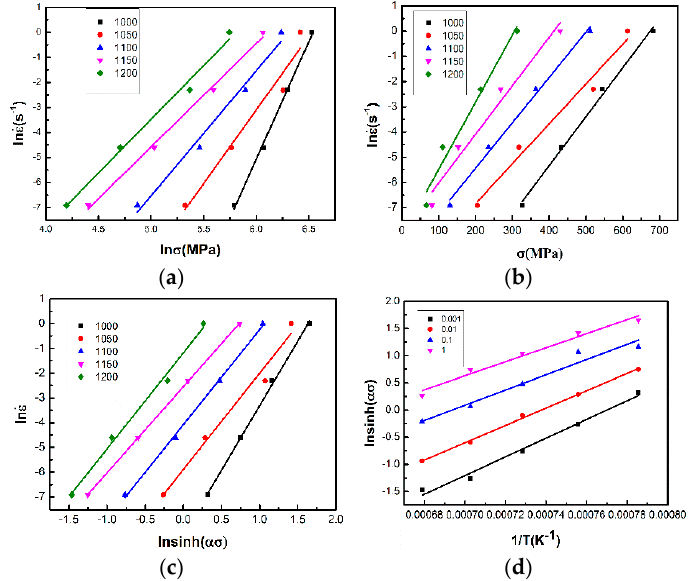
Figure 3. Plot of ( a ) ln ε ‐ ln σ ; ( b ) ln ε ‐σ ; ( c ) ln ε ‐ ln[sinh( ασ )]; ( d ) ln[sinh( ασ )] ‐ 1/ T . It is important to note that the flow stress is taken at the peak strain.